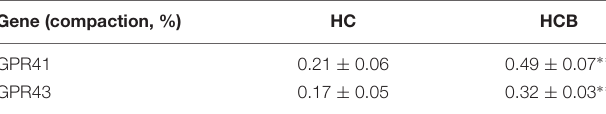
TABLE 3 | The level of chromatin compaction of GPR41/43 in the cecum.